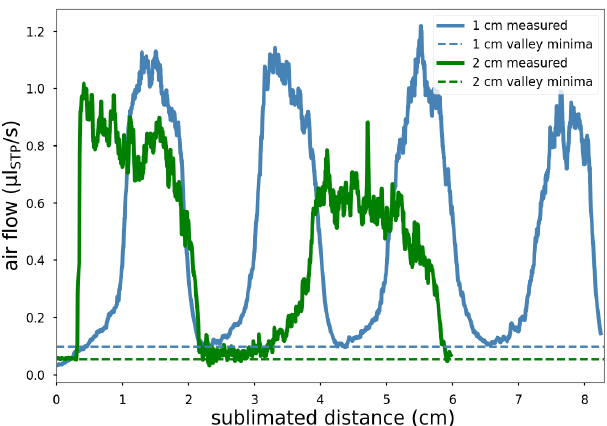
Figure 4. Released air flow (solid lines, “measured”) during subli- mation (100W laser power) of alternating stacked gas-free ice (FI) and bubble ice (BI). Blue is alternating 1cm ice layers, starting with FI. Green is 2cm layers starting with BI. The dashed lines mark comparable minima during the sublimation of FI that form extrac- tion flow “valleys”. For the sublimated distance, a conversion factor of 1cm per 1050s is